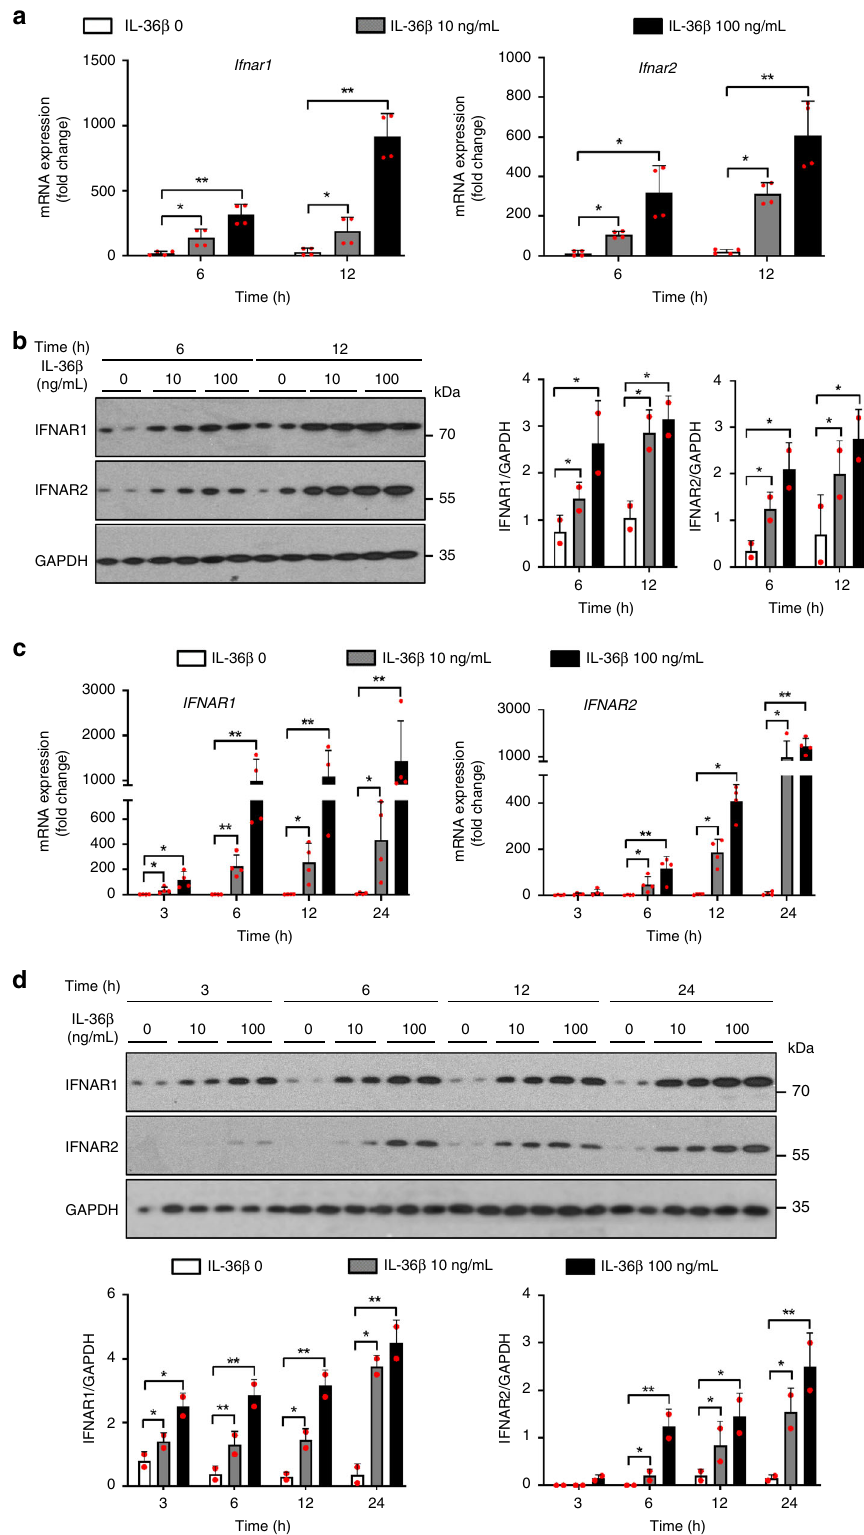
Fig. 5 IL-36 β activates expression of IFNAR1 and IFNAR2. a Ifnar1 and Ifnar2 mRNA expression was analyzed by real-time PCR in male mouse primary keratinocytes treated with medium only or IL-36 β as indicated. b Mouse IFNAR1 and IFNAR2 protein expression was examined by western blotting and ImageJ analyses. c Human keratinocytes were treated with medium only or IL-36 β and expression of IFNAR1 and IFNAR2 mRNA determined by real-time PCR. d Expression of human IFNAR1 and IFNAR2 protein was examined by western blotting and ImageJ analyses. a – d Quantitative data are shown as means ± SD. * p < 0.05 (one-way ANOVA, n = 2 biologically independent samples per treatment group); ** p < 0.01. Each red dot represents a single data point. Source data are provided as a Source Data fi